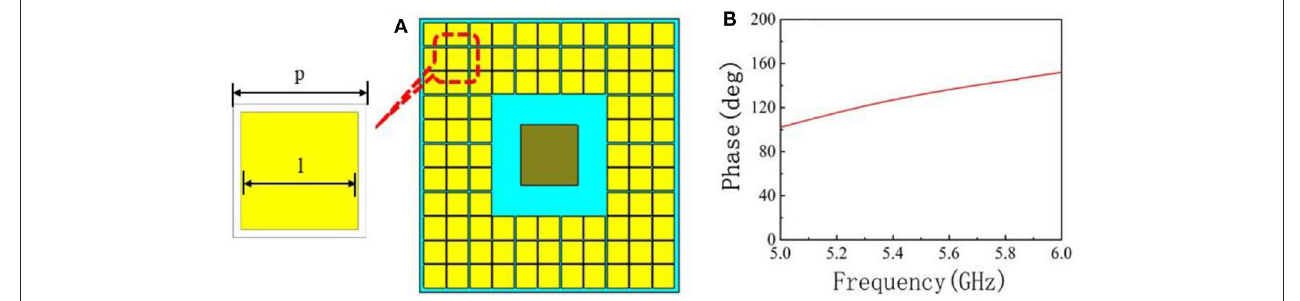
FIGURE 7 | (A) The radiation patch surrounded with patch array. (B) The phase of reflection wave for x-polarized incident wave.